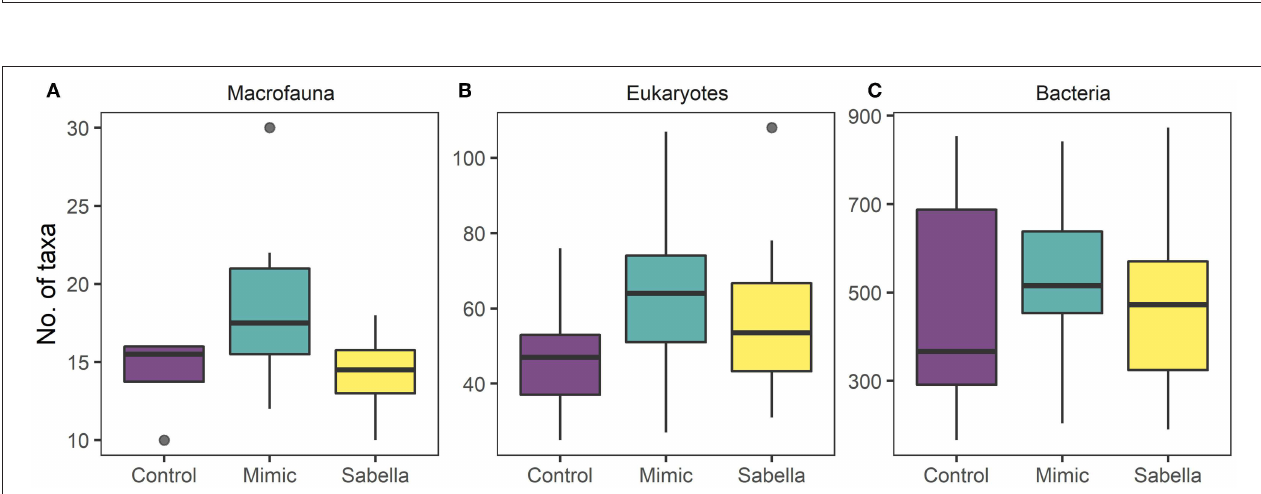
FIGURE 5 | Boxplots of taxa richness for (A) , macrofauna (B) , eukaryote (C) , and bacterial communities in “Control” (purple), “Mimic” (green) and “ Sabella ” (yellow) experimental plots.